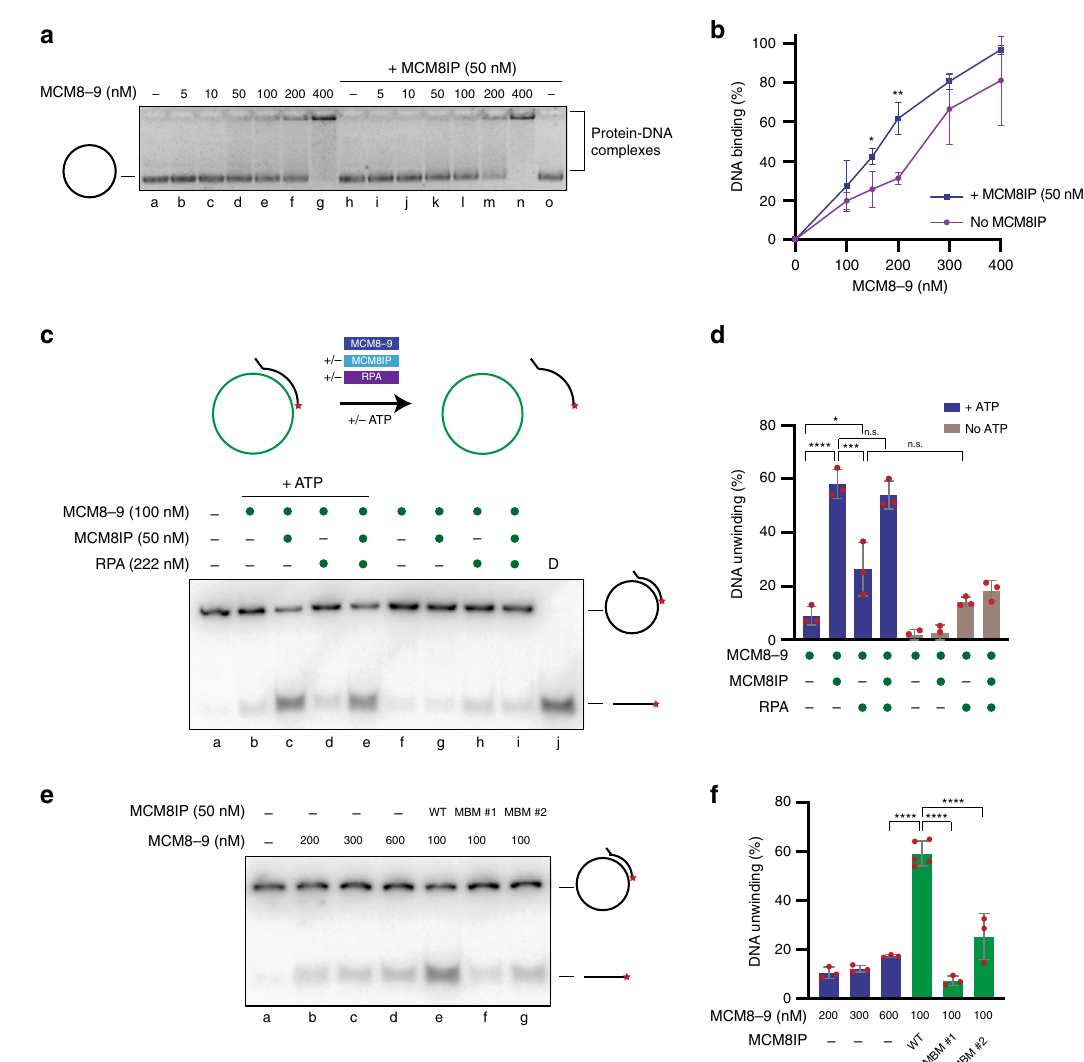
Fig. 4 Analysis of the DNA binding and helicase activities exhibited by MCM8-9 and MCM8IP. a Representative gel of an electrophoretic mobility shift assay with a ssDNA plasmid (M13mp18, 100 ng per reaction) incubated with increasing amounts of recombinant MCM8-9 in the presence or absence of MCM8IP (50 nM). b Graphical representation of the percentage of ssDNA plasmid bound by recombinant MCM8-9 in the presence or absence of MCM8IP in electrophoretic mobility shift assays conducted as in ( a ). The mean ± SD of three or more independent experiments ( n = 3 – 4) is presented. Statistical analysis was conducted using Student ’ s t -test (* p < 0.05, ** p < 0.01, two-tailed). c Schematics of a DNA unwinding reaction conducted using a